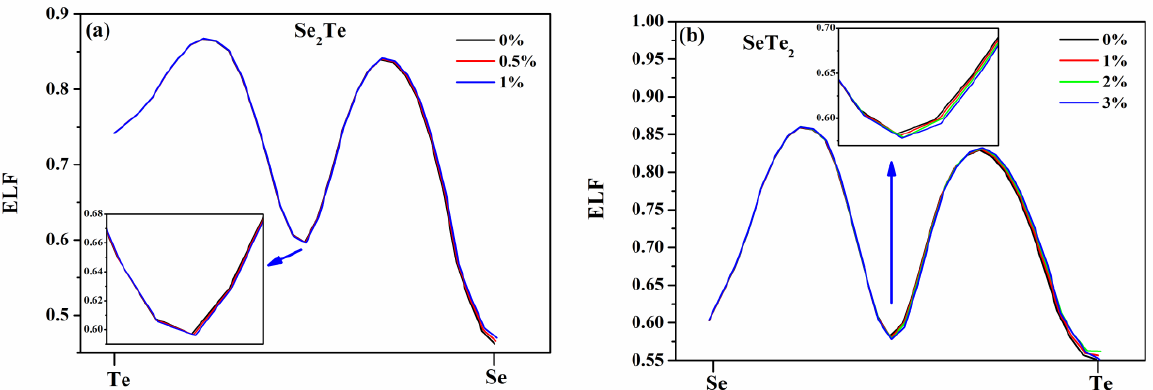
Figure 4. (Color online) The ELF profile from ( a ) Te to Se atom in the Se 2 Te monolayers and ( b ) Se to Te atom in the SeTe 2 monolayers as indicated by the red arrow in Figure 1b,d, respectively. The inset shows the ELF value of the middle region of the two atoms.